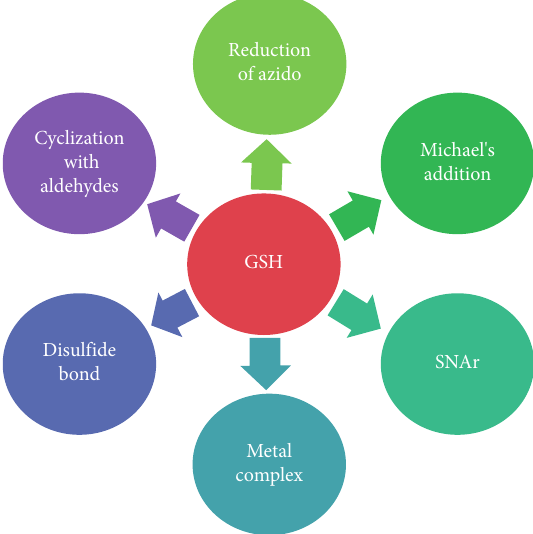
Figure 1: The reaction types of